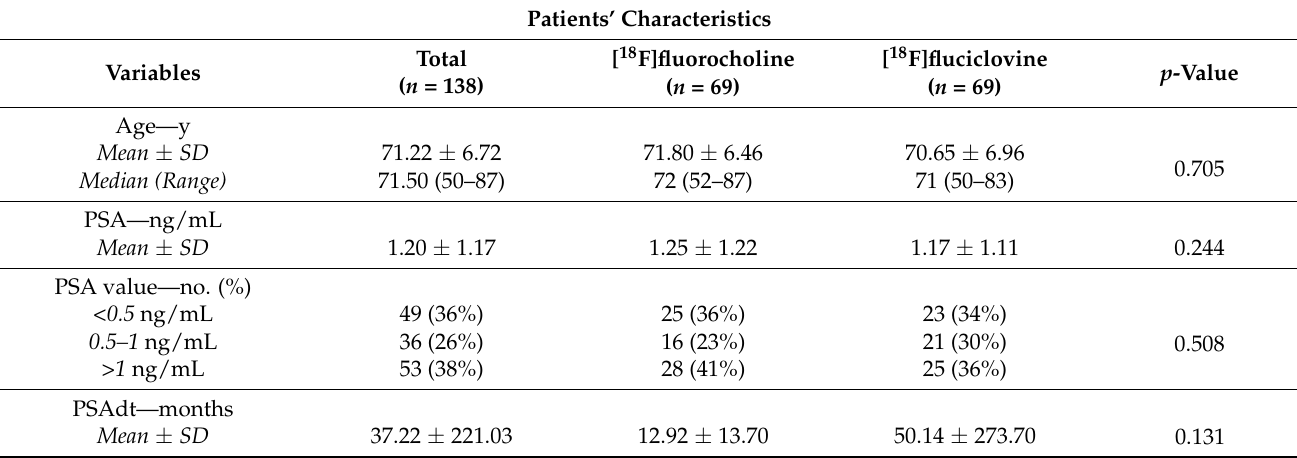
Table 1. Patients’ characteristics ( n =